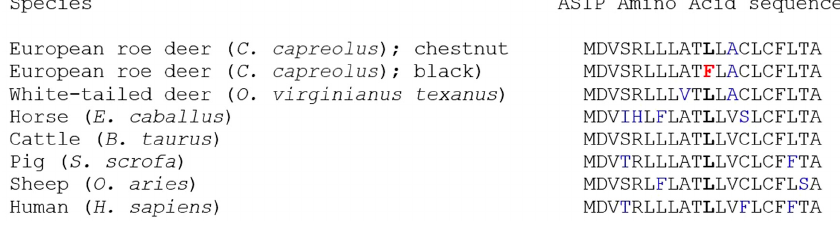
Figure 2. Alignment of amino acid sequences for the first part of ASIP exon 1 (AS1 to AS20) for white- tailed deer (GenBank XM_020889165), horse (GenBank AF288358), cattle (GenBank AH013175), pig (GenBank GQ373180), sheep (GenBank EU420022), and human (GenBank NM_001672). AA p.11 is bold, change in melanistic European roe deer is red, interspecific amino acids are